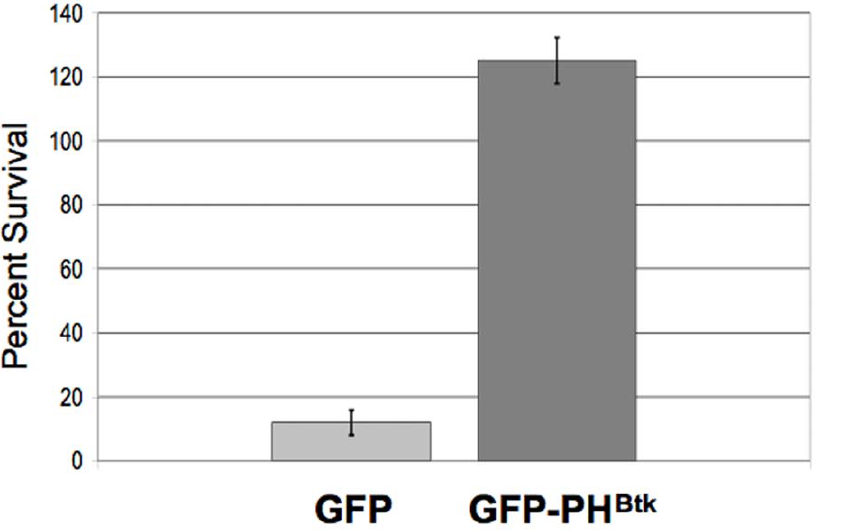
Figure 2. Tubercidin-loaded erythrocytes are less toxic to an E.histolytica cell line with a phagocytosis defect. Trophozoites over- expressing a GFP-tagged version of a pleckstrin homology (PH) domain from mammalian Bruton’s tyrosine kinase (GFP-PH Btk ), which exhibit reduced phagocytosis [22] or a control cell line over-expressing GFP alone (GFP) were exposed to tubercidin-loaded erythrocytes three times and viability was assessed 48 hours after treatment. The data are reported as a percent of the starting number of viable amoebae before treatment. The data represent the mean 6 S.D of 3 trials. The phagocytic mutant was insensitive to treatment with tubercidin-charged hRBCs as evidenced by . 100% survival (growth) in the presence of selection. This indicates that the selection scheme may be used to enrich for phagocytosis mutants from a population of cells.